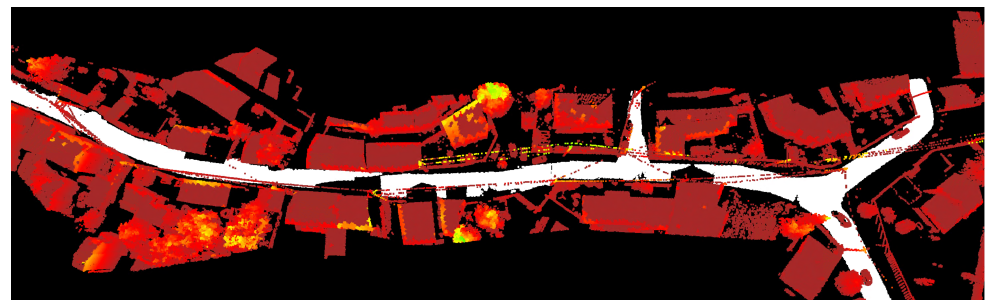
Figure 14. Height below, KNN =